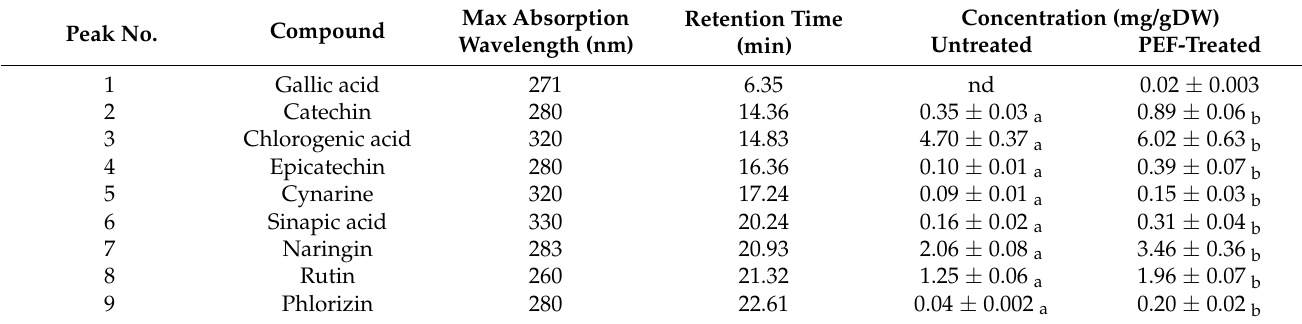
Table 2. Concentrations (mg/gDW) of gallic acid, catechin, chlorogenic acid, epicatechin, cynarine, sinapic acid, naringin, rutin and phlorizin (HPLC/PDA analysis) in the extracts from untreated and PEF-treated artichoke stems.